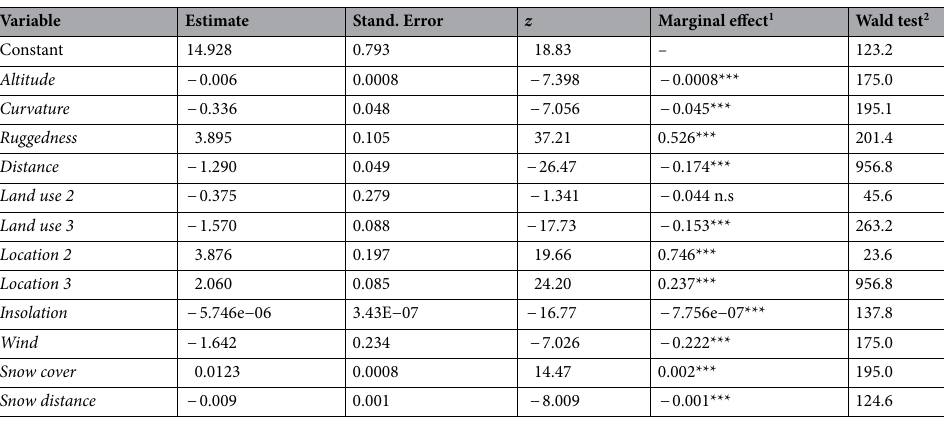
Table 2. The results of the logistic GLM estimation for clusters with high and low values (binary variables, hot and cold spots). Two variables were eliminated from the model: Exposure and Slope due to high collinearity with Ruggedness and Insolation. For the same reason, the categorical variables Land use 1 and Location 1 were automatically removed. For the description of the variables, see Table 1. 1 *** p < 0.001, n.s.—not significant. 2 All values at p < 0.001.